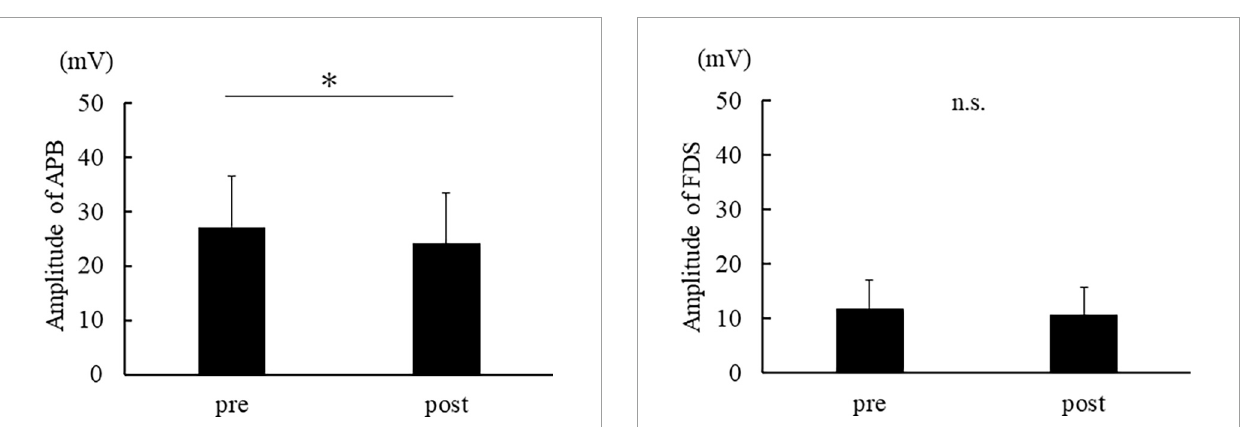
significantly increased compared to pre, and APB muscle activity in post-was significantly decreased compared to pre. (2) N30 at F3 electrode; P25, N33, and P45 at C3 (cid:48) electrode; and P25 and P45 at P3 electrode during the BR task were attenuated compared to rest. (3) No significant difference was found between pre and post in SEP components. (4) P45 amplitude at C3 (cid:48) electrode